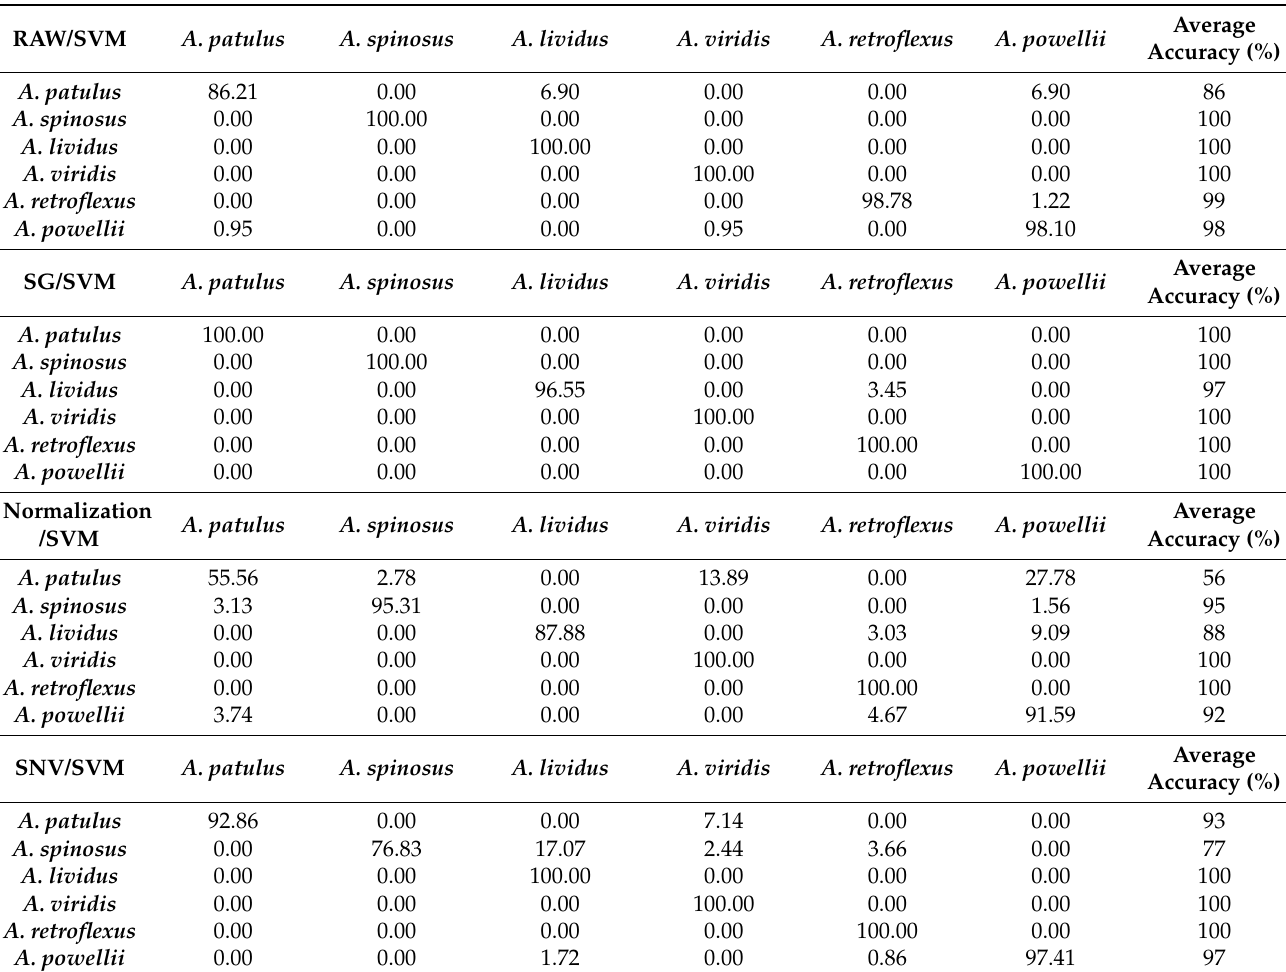
Table 5. Confusion matrix of species discrimination using different preprocessing methods and models.